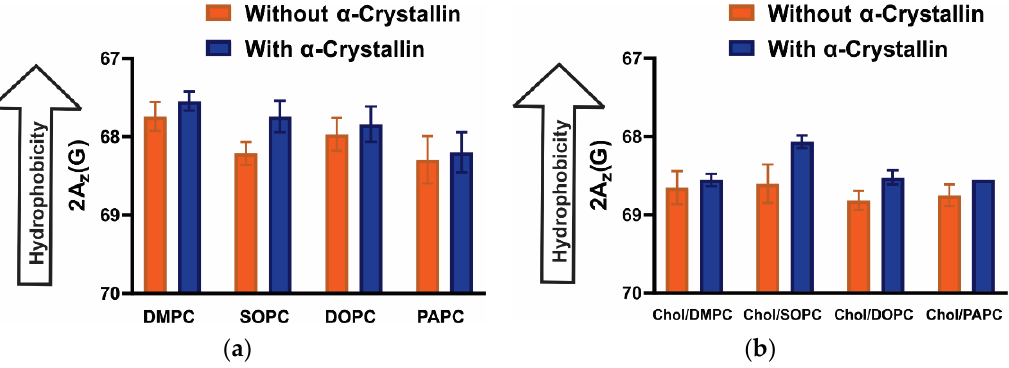
Figure 6. ( a ) Shows the profiles of hydrophobicity (2A z ) with and without α -crystallin for DMPC, SOPC, DOPC, and PAPC membranes; ( b ) shows the profiles of hydrophobicity with and without α -crystallin for Chol/DMPC, Chol/SOPC, Chol/DOPC, and Chol/PAPC membranes with Chol and PL mixing ratio of 0.3. Membrane and α -crystallin membrane samples incubated at 37 °C for 16 h, which are used to measure the MSO shown in Figure 2, are used for hydrophobicity measurements at − 165 °C. The 52.6 µM of α -crystallin is used for all the hydrophobicity measurements presented for the α -crystallin membrane samples in Figure 6. Our previous study [48] explains a detailed method to calculate hydrophobicity. The data points are expressed as mean ± standard deviation from three independent experiments. Without Chol (Figure 6a), the hydrophobicity for all mem- branes slightly increases with α -crystallin, representing that the α -crystallin-membrane association slightly increases hydrophobicity (decreases polarity) near the headgroup regions of membranes. Interestingly with Chol (Figure 6b), the hydrophobicity for all membranes slightly increases with α - crystallin; even no or minimal association of α -crystallin is observed with Chol/DOPC and Chol/PAPC membranes. This suggests that the α -crystallin close to these membrane surfaces expels the water molecules around the headgroup regions, increasing hydrophobicity (decreasing polar- ity).